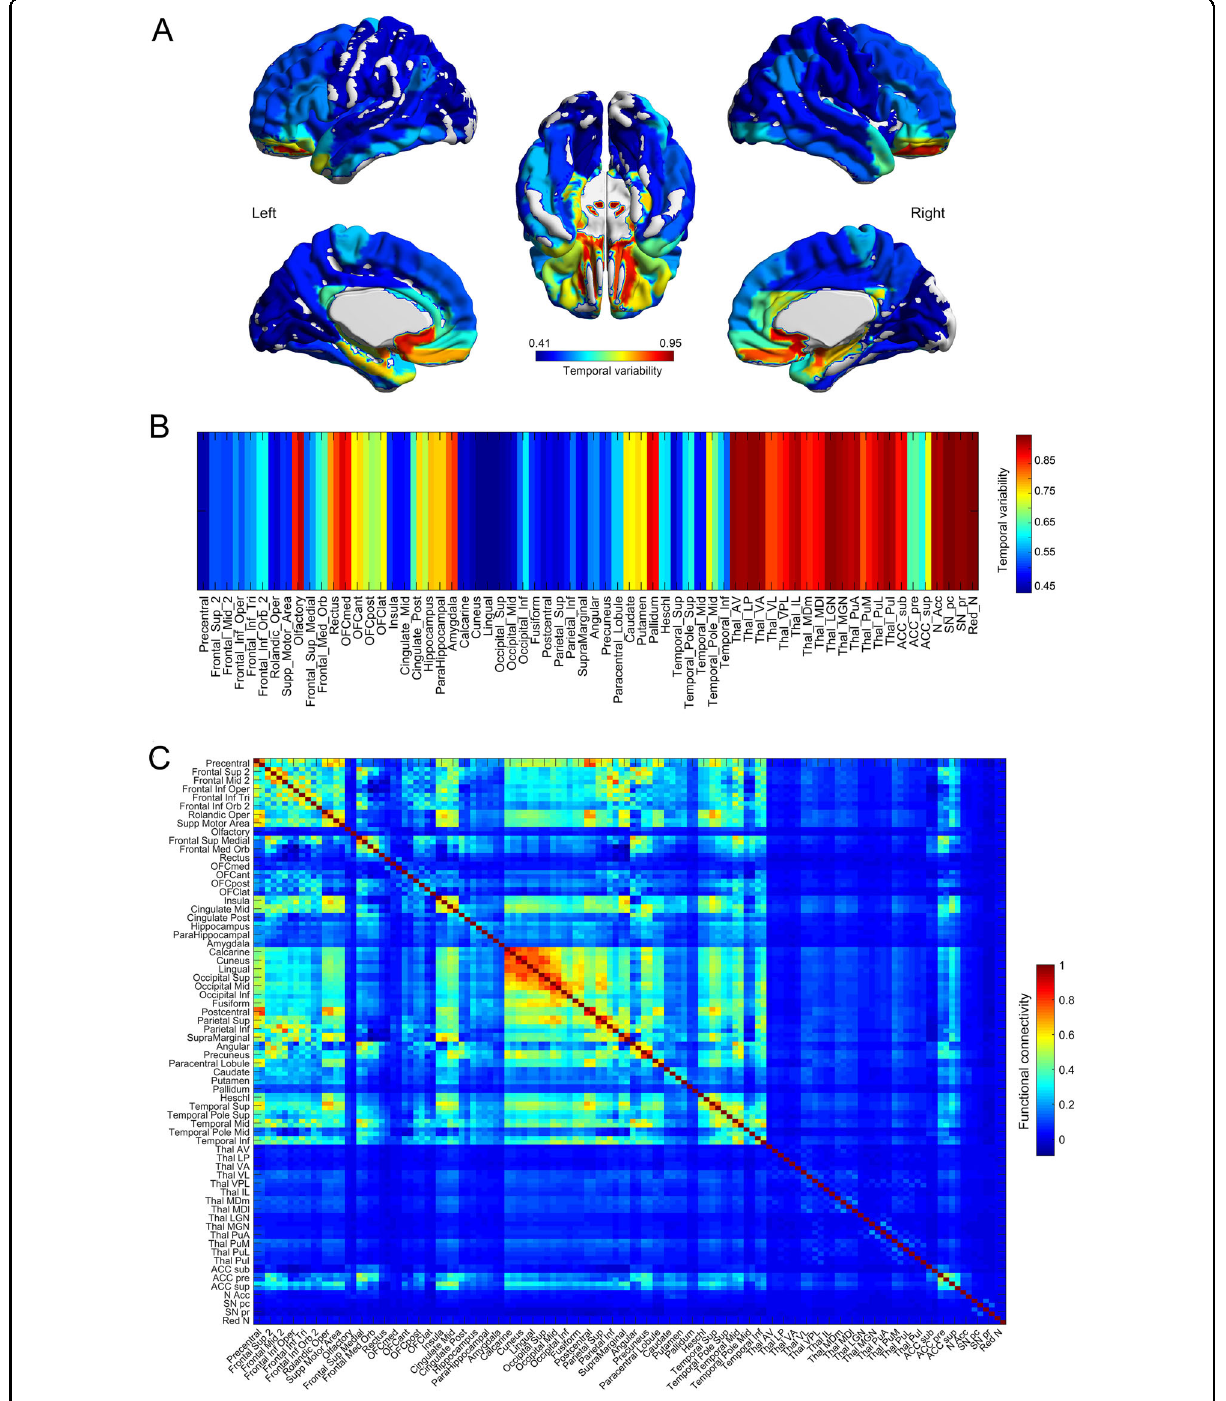
Fig. 1 The temporal variability of functional connectivity is related to the mean functional connectivity of brain regions. A A brain surface diagram (based on AAL3) showing the temporal variability of the functional connectivity of different brain regions. The data are from the Human Connectome Project (HCP). B The temporal variability of the functional connectivity of different AAL3 regions. C The functional connectivity between AAL3 areas from the